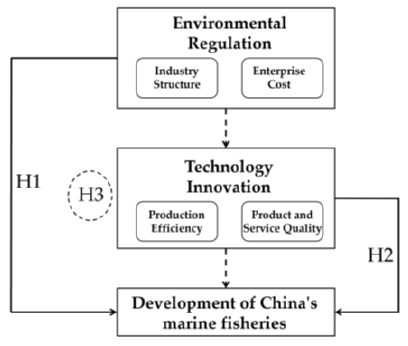
Figure 1. Influence